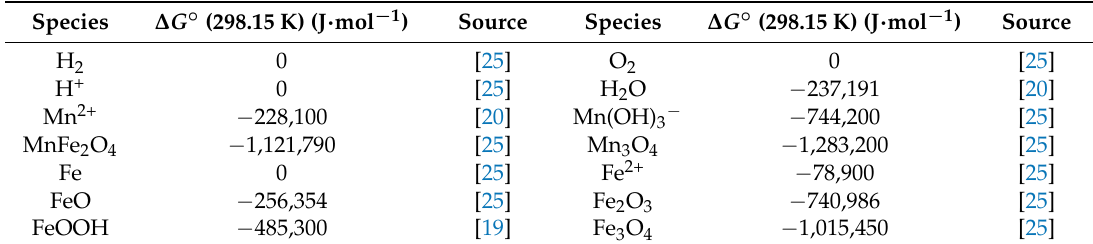
Table 2. Thermodynamic data of used species during the corrosion process of the tested medium-Mn steel.